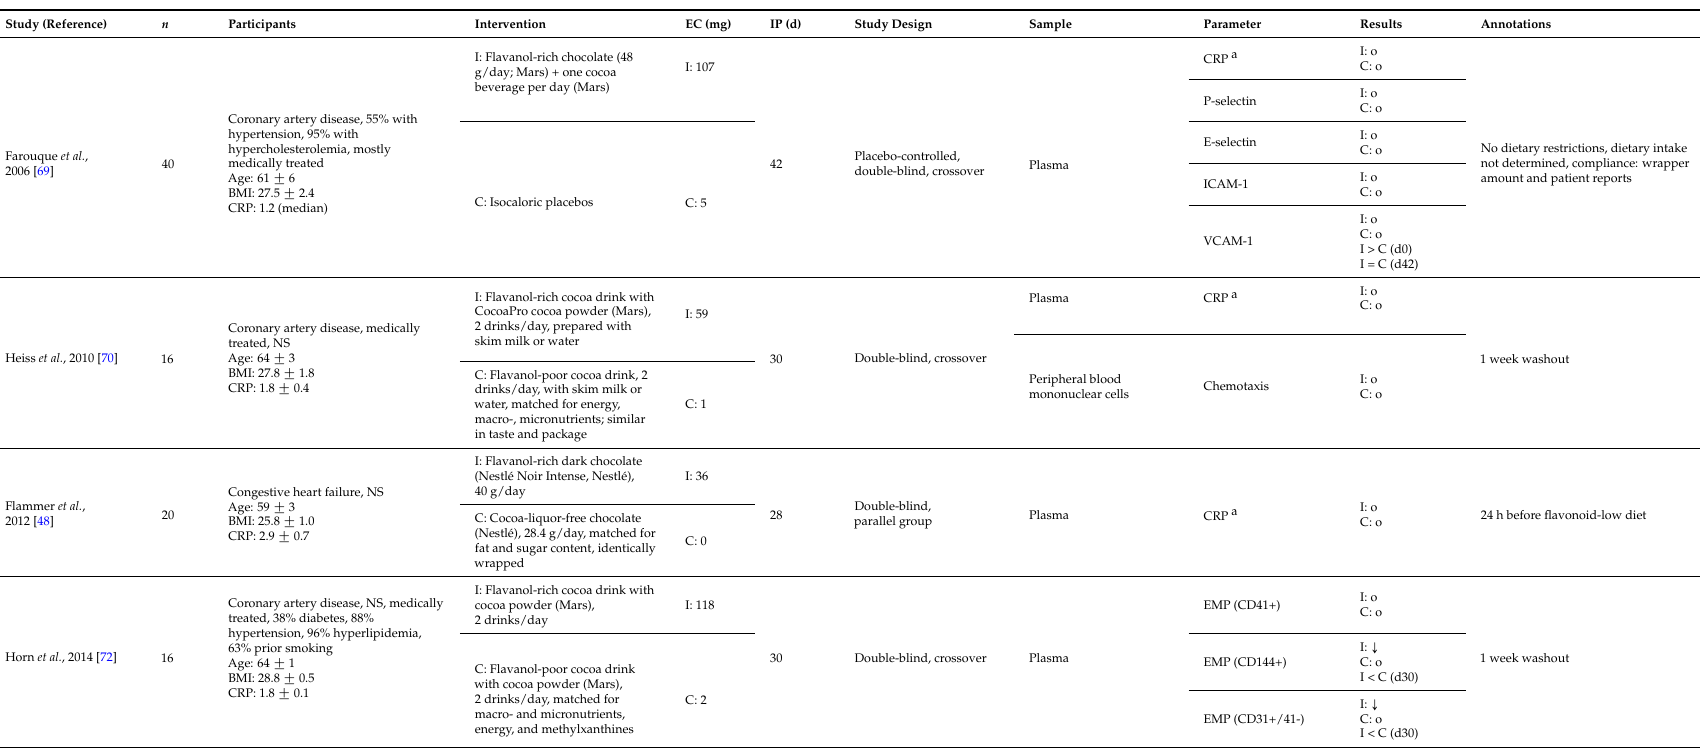
a determined by high-sensitivity test kits for C-reactive protein. BMI: body mass index; C: control; d: days; CRP: C-reactive protein; EC: epicatechin; EMP: endothelial microparticles; I: cocoa intervention; ICAM-1: intercellular adhesion molecule-1; IL-6: interleukin-6; IP: intervention period; n.d.: no data available; PMP: platelet-derived microparticles; VCAM-1: vascular cell adhesion molecule-1; Ó : decrease; o: no changes; ∆ difference pre- vs. post-consumption values. Data on age (years), BMI (kg/m 2 ), and CRP (mg/L) are means ˘ SEM if not indicated otherwise. Means were calculated as weighted means from the data of individual groups if not provided by the authors. Missing SEMs were calculated by SDs, of individual groups. n refers to the number of participants for whom data on inflammatory markers were